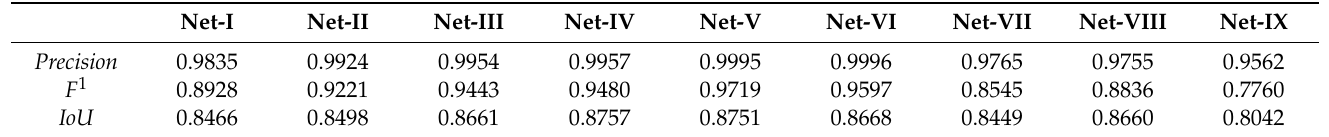
Table 16. Class metrics of cable class of testing images with the C-T ratio of 0.08.